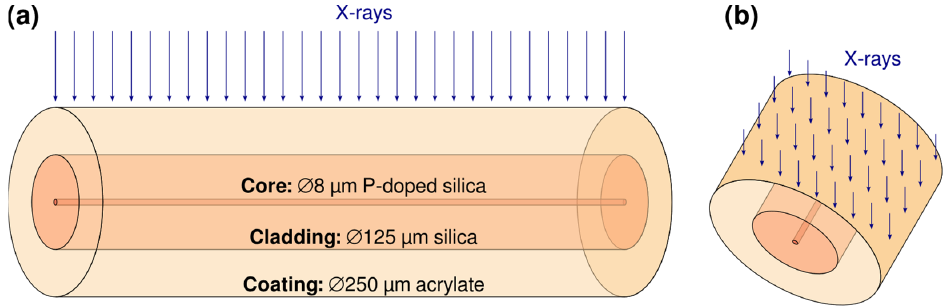
Figure 3. Geometry of the Monte-Carlo simulation of dose deposition in the irradiated OF, viewed ( a ) from the side, ( b ) from the top.